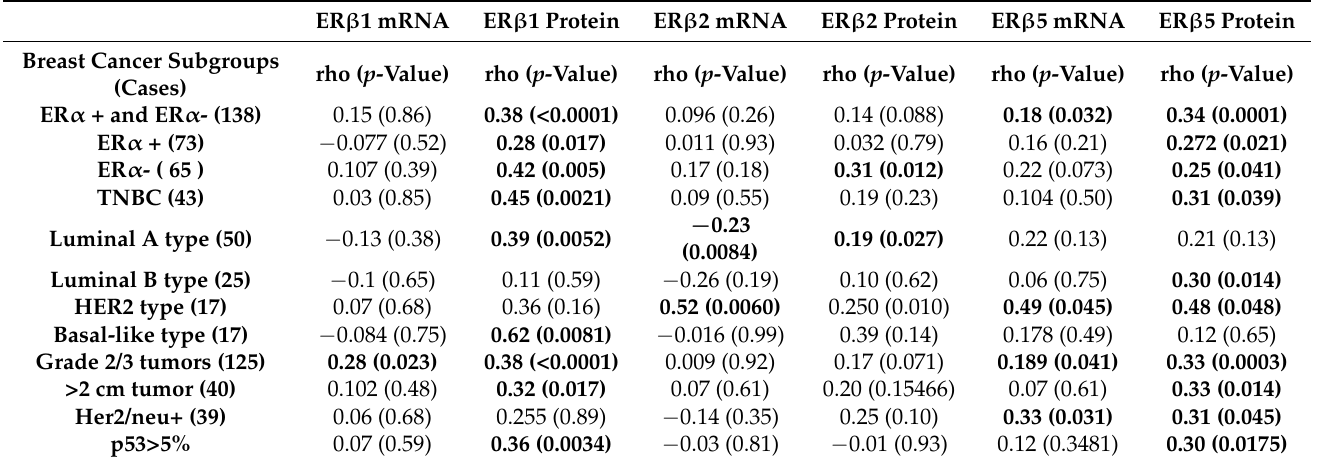
Table 4. Spearman rank-order correlation between ER β isoform mRNA and protein expression